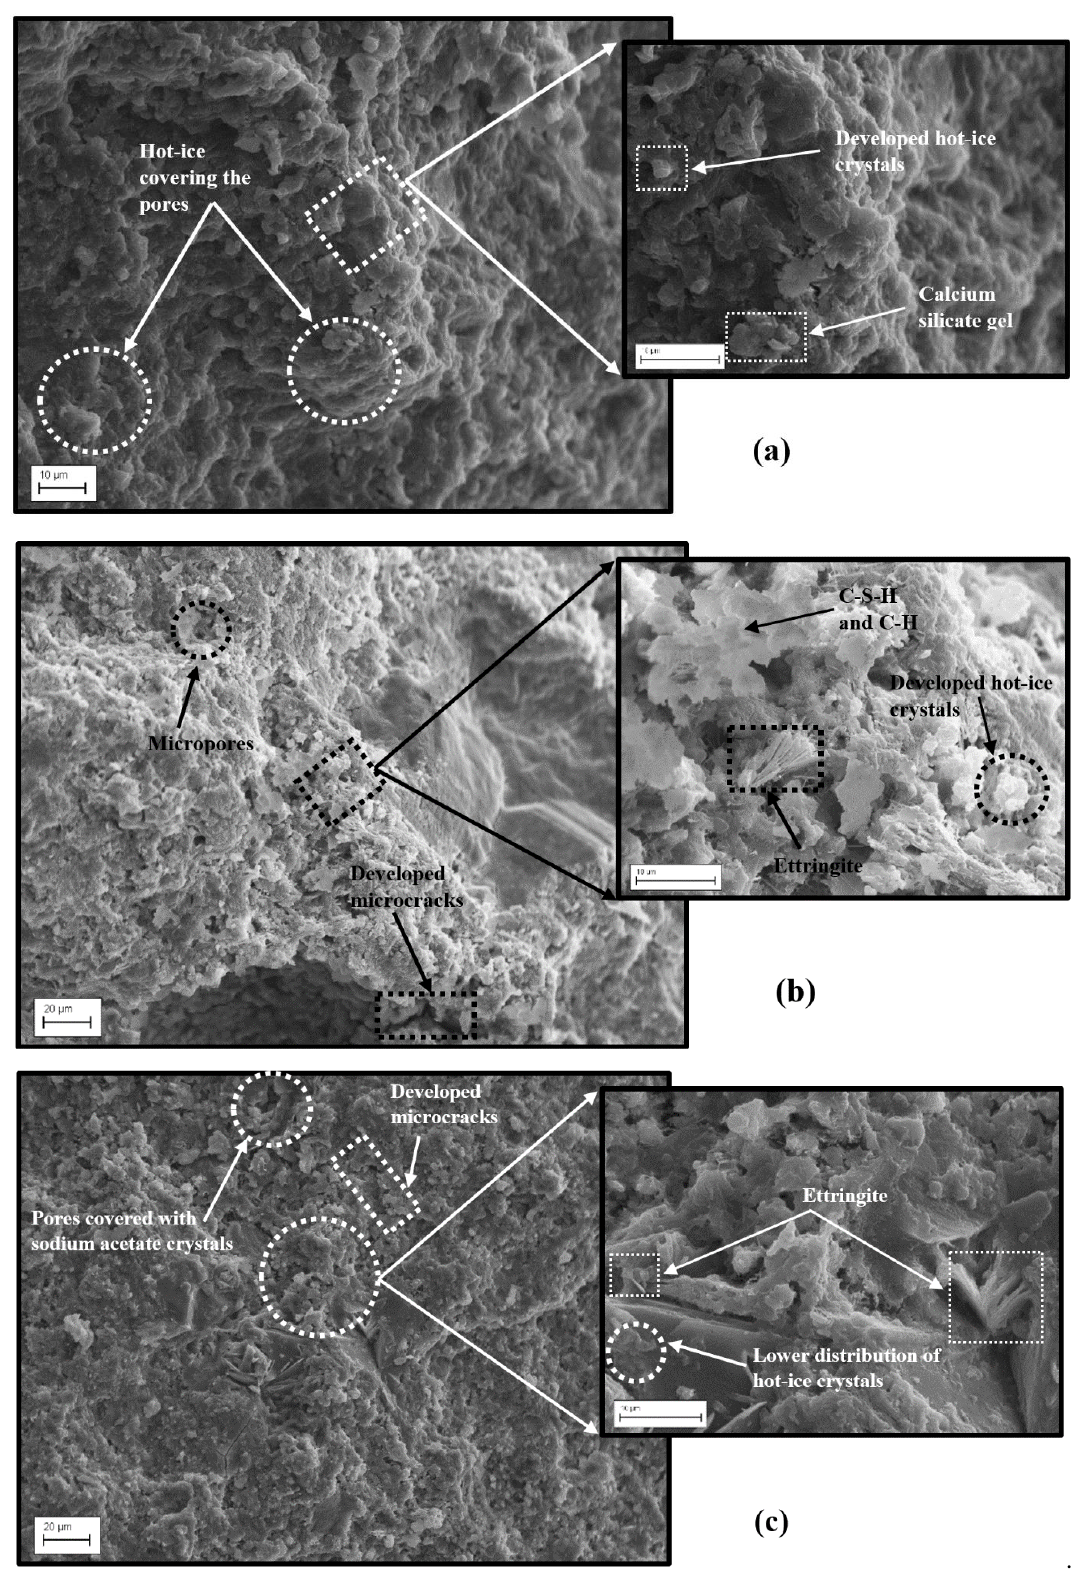
Figure 2. Microstructural analysis for PCC pavement treated with sodium acetate and cured in: ( a ) water bath, ( b ) natural environment (outdoor), and ( c ) pond water.